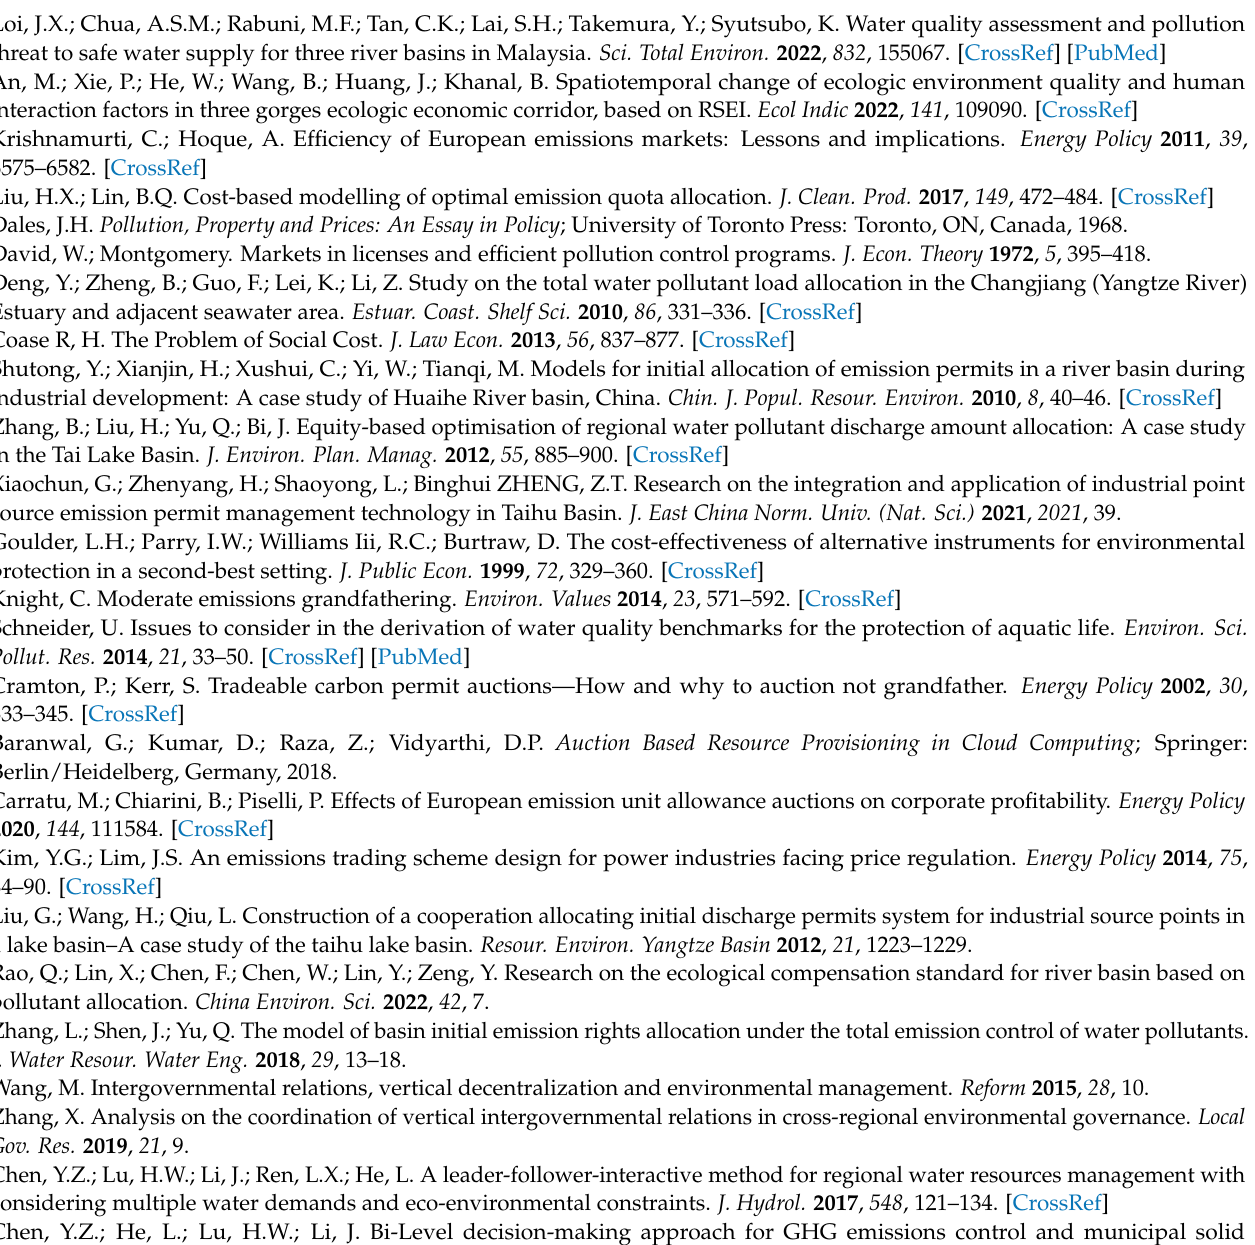
Provinces (Autonomous